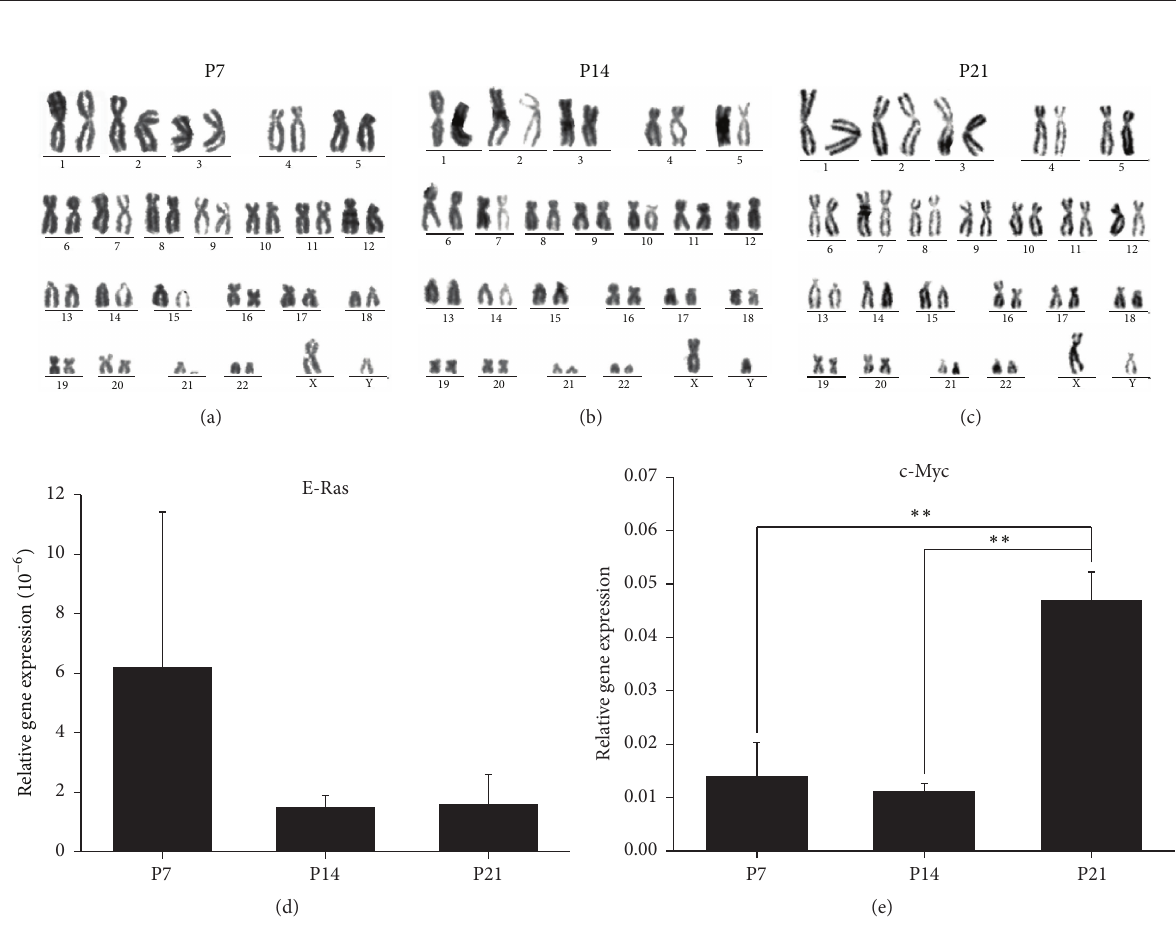
Figure 3: Chromosome analysis and the expression of oncogenes, E-Ras and c-Myc, in WJ MSCs (Wharton’s jelly-derived mesenchymal stem cells)intheearly,middle,andlatephases.(a–c)Chromosomeanalysisindicatedthatserialpassagedidnotchangethenumberofchromosome in WJ MSCs regardless of the phases. (d) There were no significant differences in E-Ras gene expression among different phases. (e) The